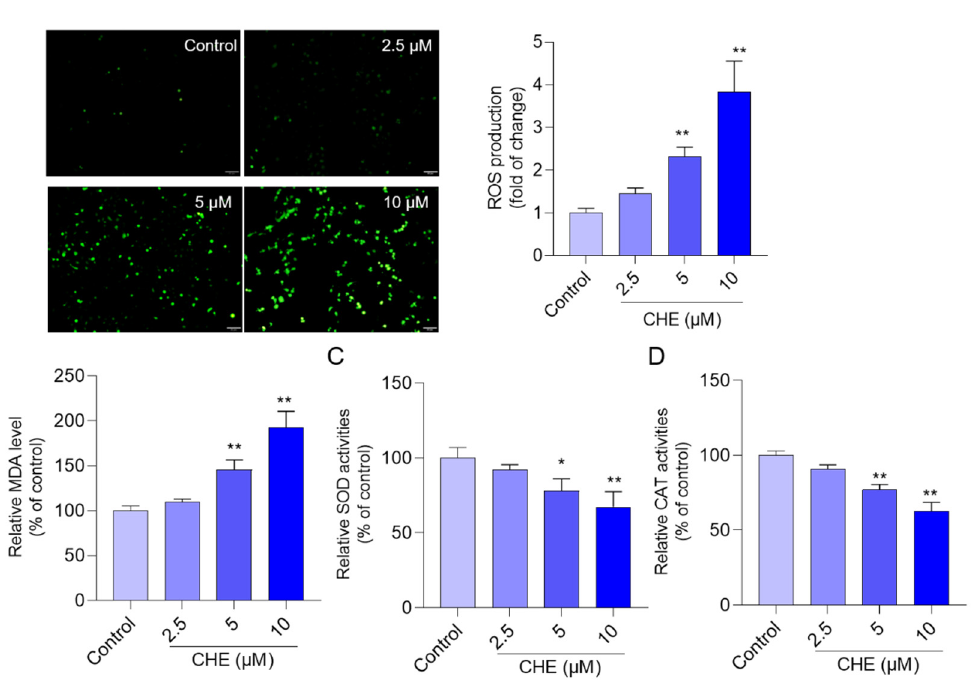
Figure 3. CHE treatment increases intracellular ROS production and MDA levels and decreases intracellular SOD and CAT activities in HepG2 cells. ( A ) The results of intracellular ROS production. HepG2 cells were treated with different doses of CHE (at 2.5, 5, and 10 μ M, respectively) for 24 h, then cells were incubated the DMEM mediums containing 2,7-dichlorofluorescein diacetate dye. The representative images (on the left) and the fluorescence intensities (on the right) are shown. Bar = 50 μ m. B-D, The levels of intracellular MDA levels, ( B ) and SOD ( C ) and CAT ( D ) activities. Data were shown as mean ± S.D. ( n =3). * p < 0.05, or ** p < 0.01, compared to the control group.